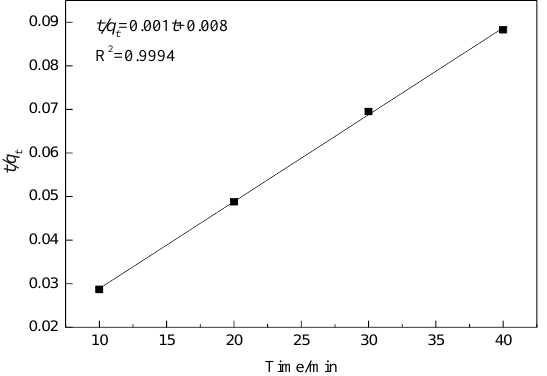
Figure 16. Regression curve of second-order rate equation.